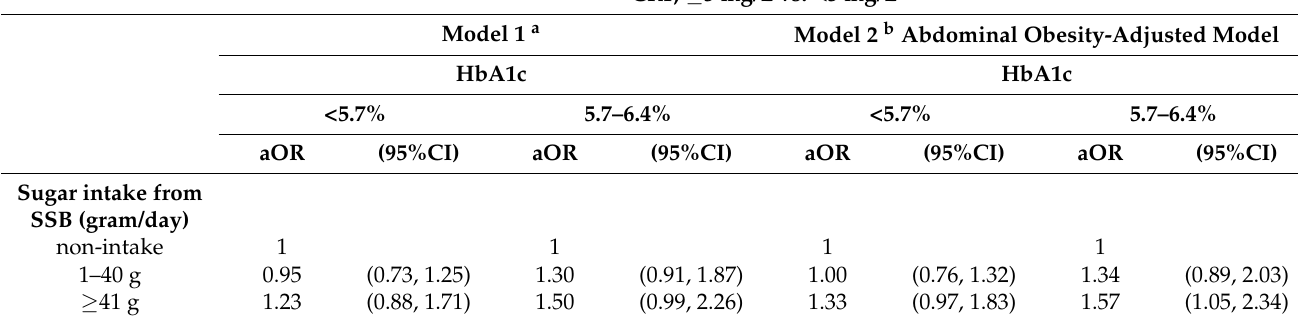
Table 3. The adjusted odds ratios (aOR) for elevated C-reactive protein ( ≥ 3 mg/L) associated with sugar intake from sugar-sweetened beverage (SSB) in non-diabetes subjects with different status of hemoglobin A1c.